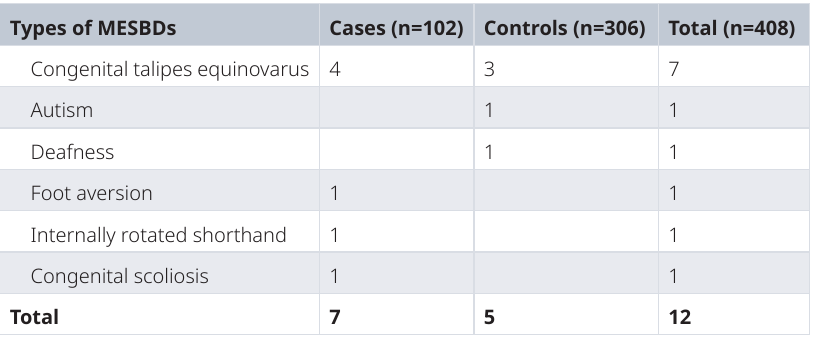
Table 3. History of siblings with birth defects among case and control subjects.